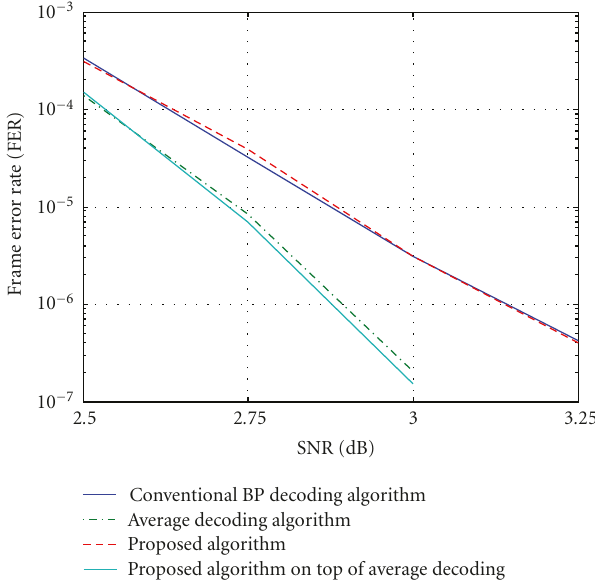
Figure 10: Performance results for PEG(1024,512) LDPC